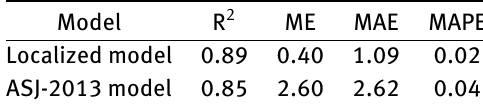
Table 4: Statistical analysis for test data set.